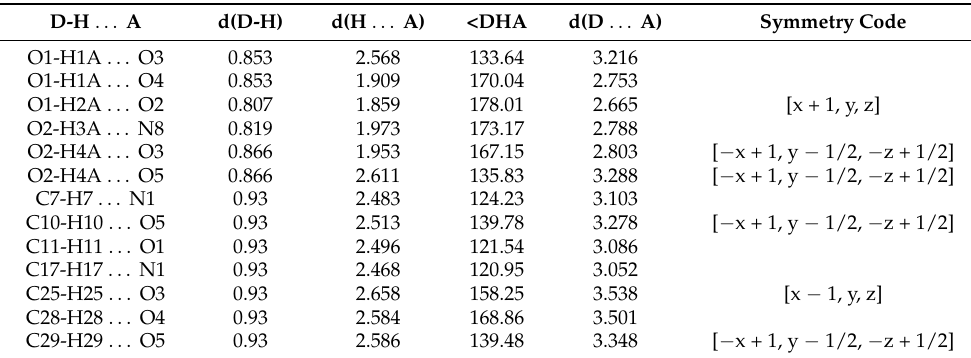
Figure 4. Packing scheme of compound 1 . The projections along [100] ( A ) and [010] ( B ) directions, respectively. Hydrogen atoms are omitted in both projections. Table 3. Hydrogen bonds in complex 1 .